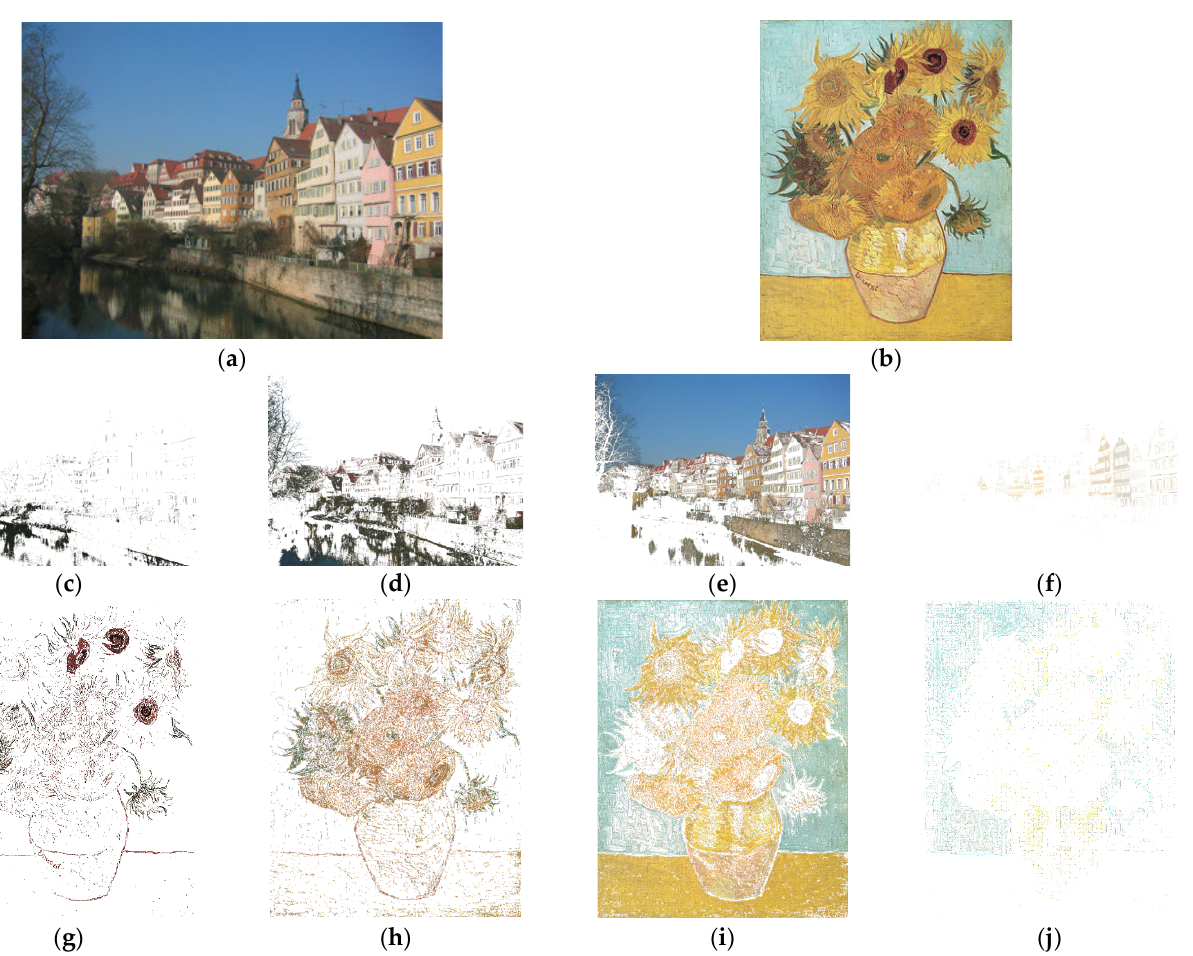
Figure 5. The result of an adaptive multilevel image color transfer between the content image and target image. ( c – f ) Three thresholds are set according to the luminance distribution of the content image, and the result of each region in the image is segmented. ( g – j ) Three thresholds are set according to the luminance distribution of the target image, and the result of each region in the image is segmented. ( a ) Content image. ( b ) Target image.